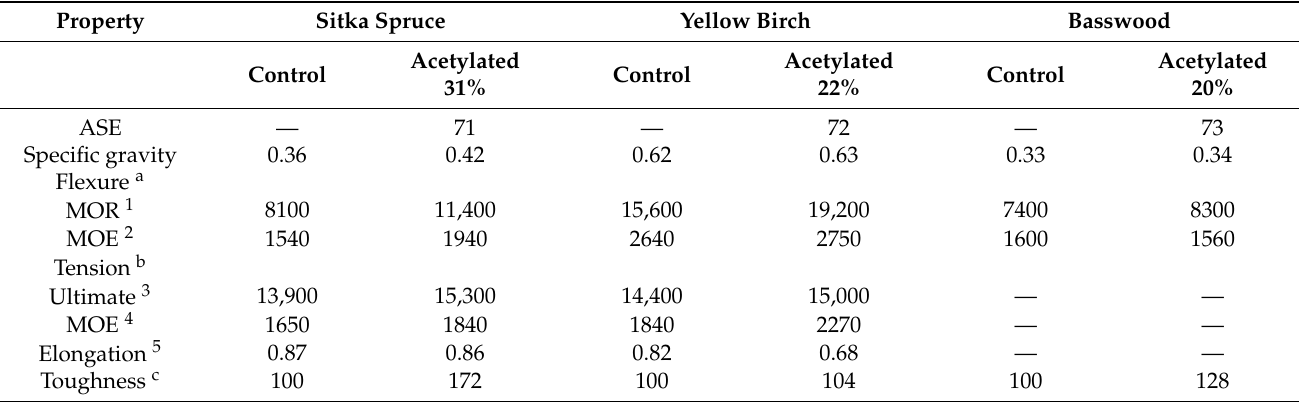
Table 4. Physical properties of control and acetylated 1/16-inch rotary-cut veneers of Sitka spruce, yellow birch, and basswood [7].